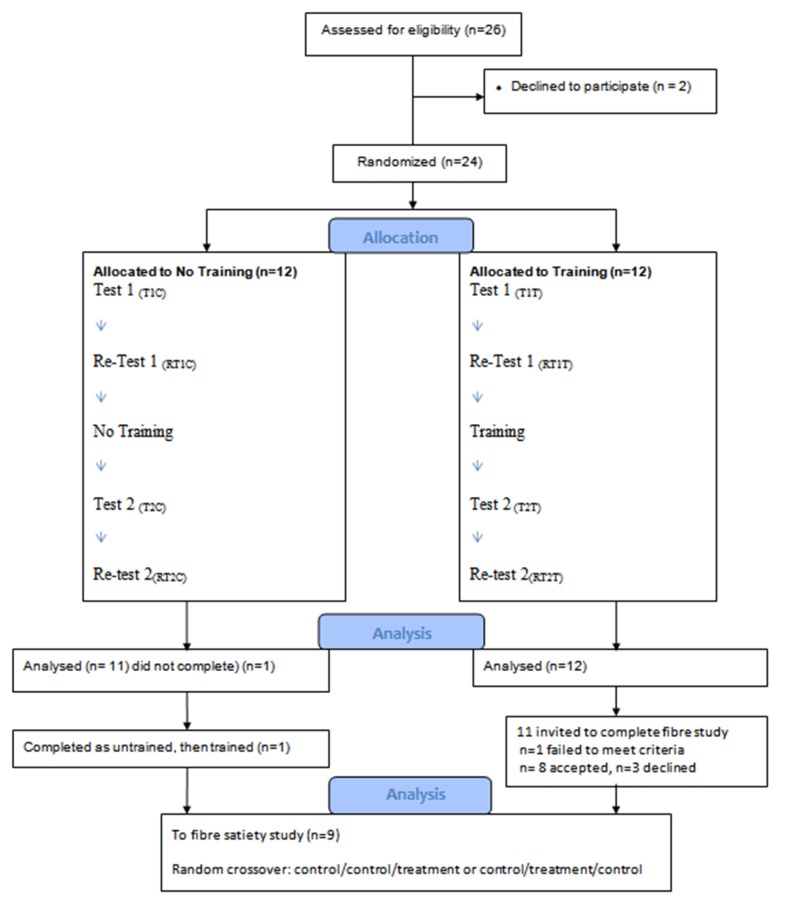
Experimental design: Training and No-training (control), and Fibre satiety study.